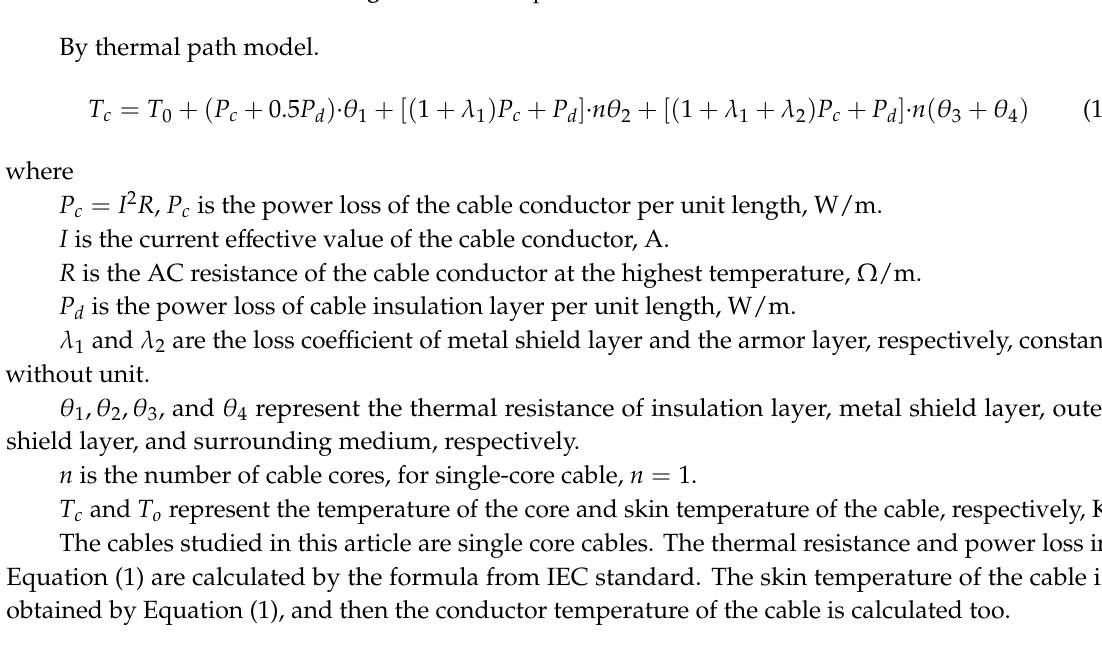
Figure 2. Thermal path model of the